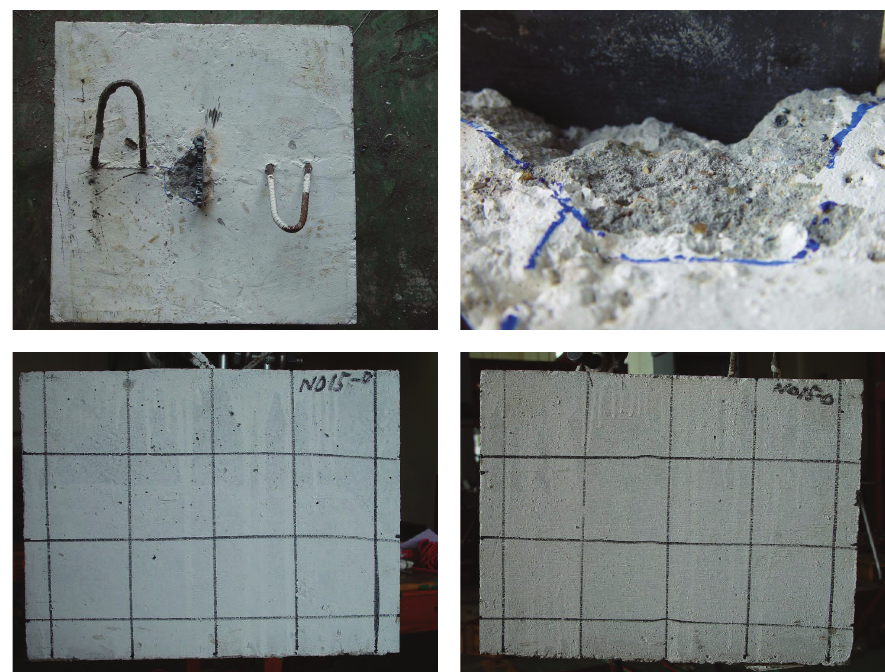
Figure 7: Failure mode of specimen PN-0015-N (Type I).